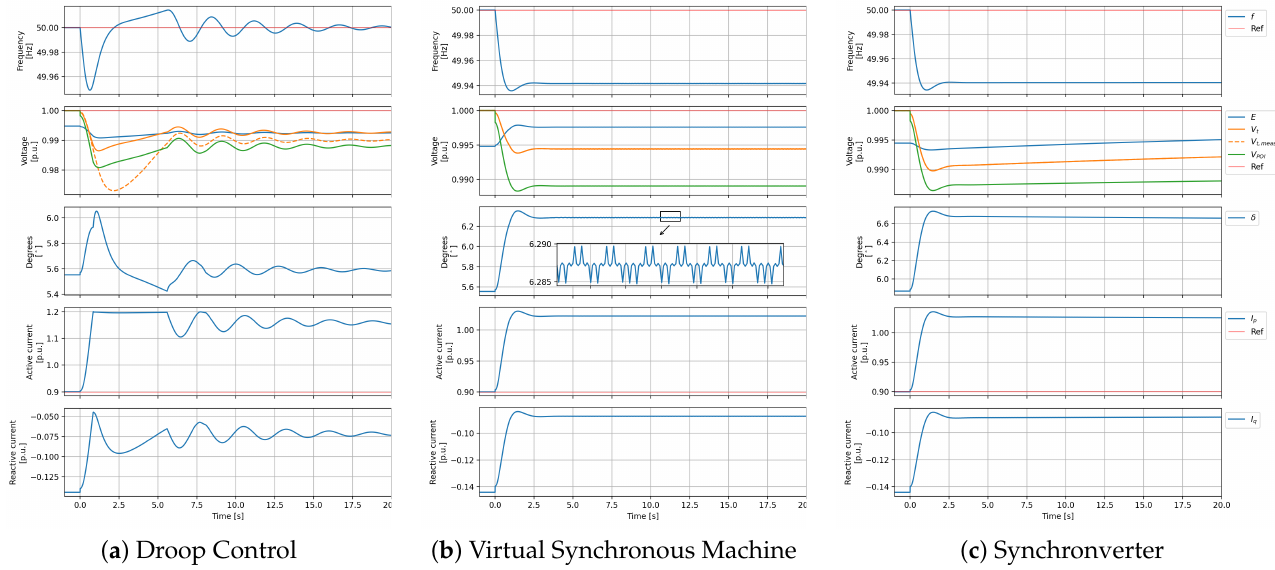
Figure 11. Types of GFM responses for test case #1 (upward frequency regulation) for the following grid conditions: SCR = 4, X / R = 2, H =